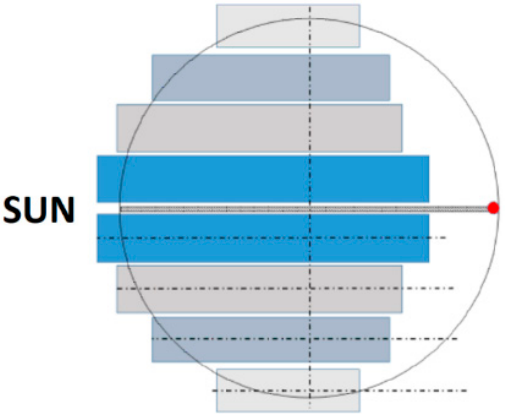
Figure 12. Top view of the mirror field on the rotating platform. Mirror stripes are shorter as they separate from the symmetry plane. Each stripe is made of several modules of 1 m 2 , which are bent as described above.